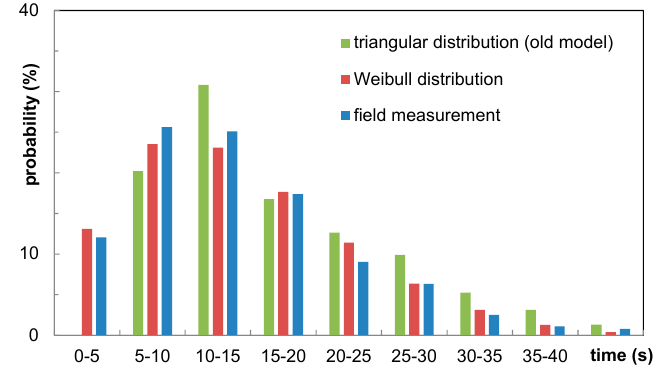
Figure 11. Time needed to store the individual amount of hand luggage.